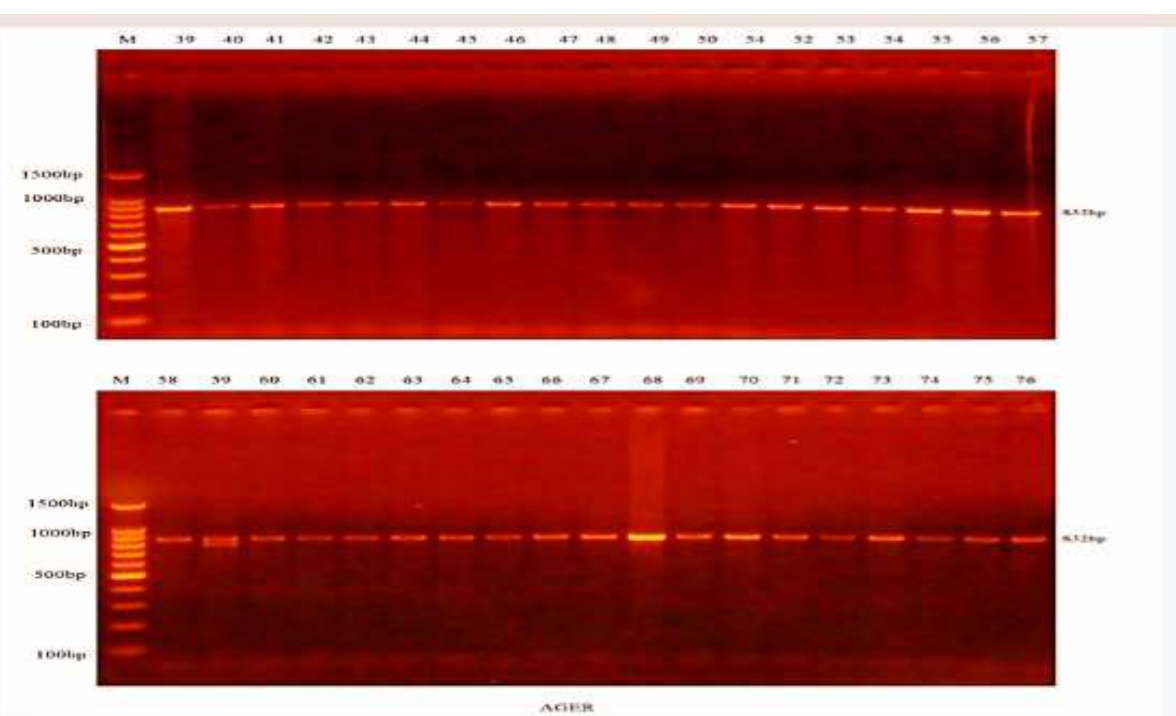
Figure 2 . Gel electrophoresis for PCR product of AGER: Results of the amplification of AGER specific gene region of Human samples were fractionated on 1.5% agarose gel electrophoresis stained with Eth.Br. M: 100bp ladder marker. Lanes 39-76 resemble 832bp PCR